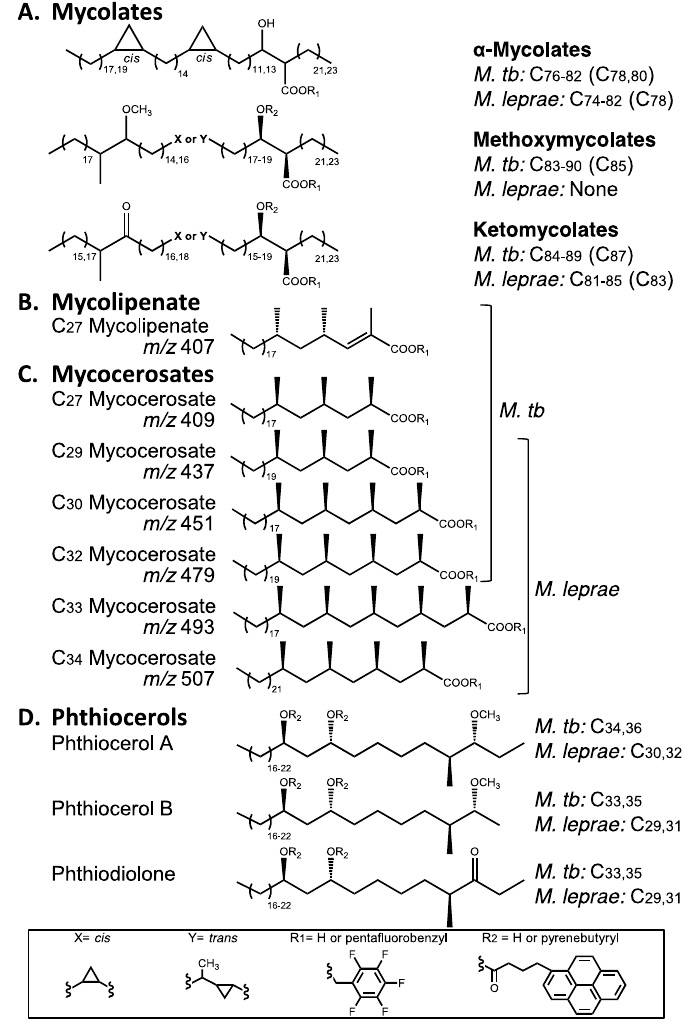
Figure 2. Key lipid biomarker structures for the recognition of ancient tuberculosis and leprosy. ( A ) Mycolic acids, occurring as characteristic homologous types; ( B ) Mycolipenic acid, restricted to the M. tuberculosis complex; ( C ) Mycocerosic acids, with C 34 being particularly diagnostic for leprosy ( m/z 507, for example, represents the ions observed on GC-MS); ( D ) Phthiocerol family, with distinct size difference between MTB and leprosy.